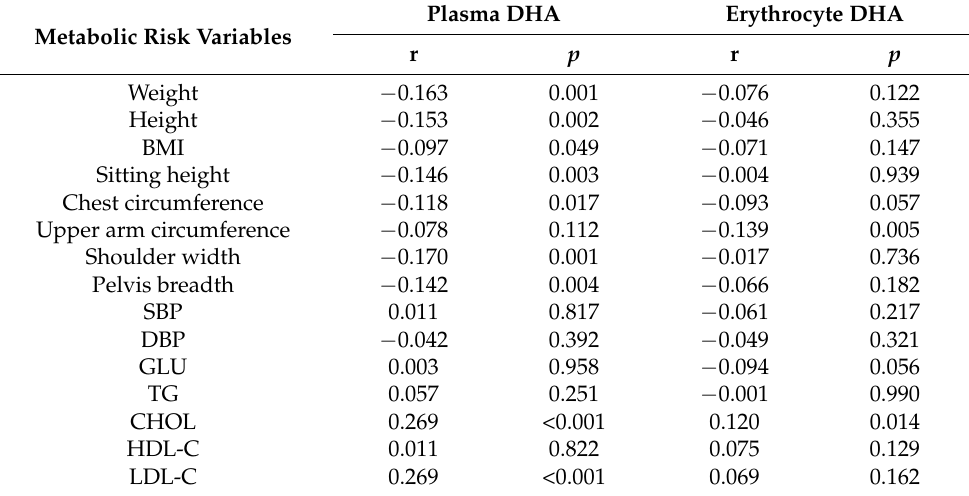
Table 4. The correlation of metabolic risk variables with plasma and erythtocyte DHA status among